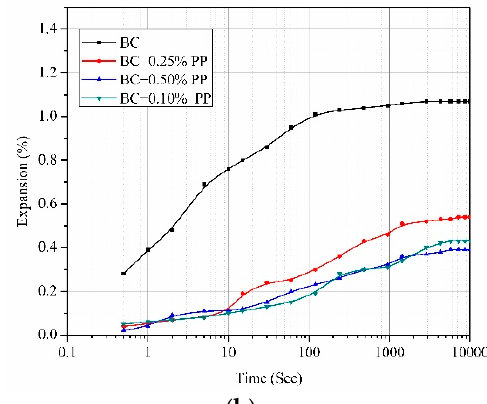
Figure 3. Combined expansion curves with and without reinforced expansive soil.